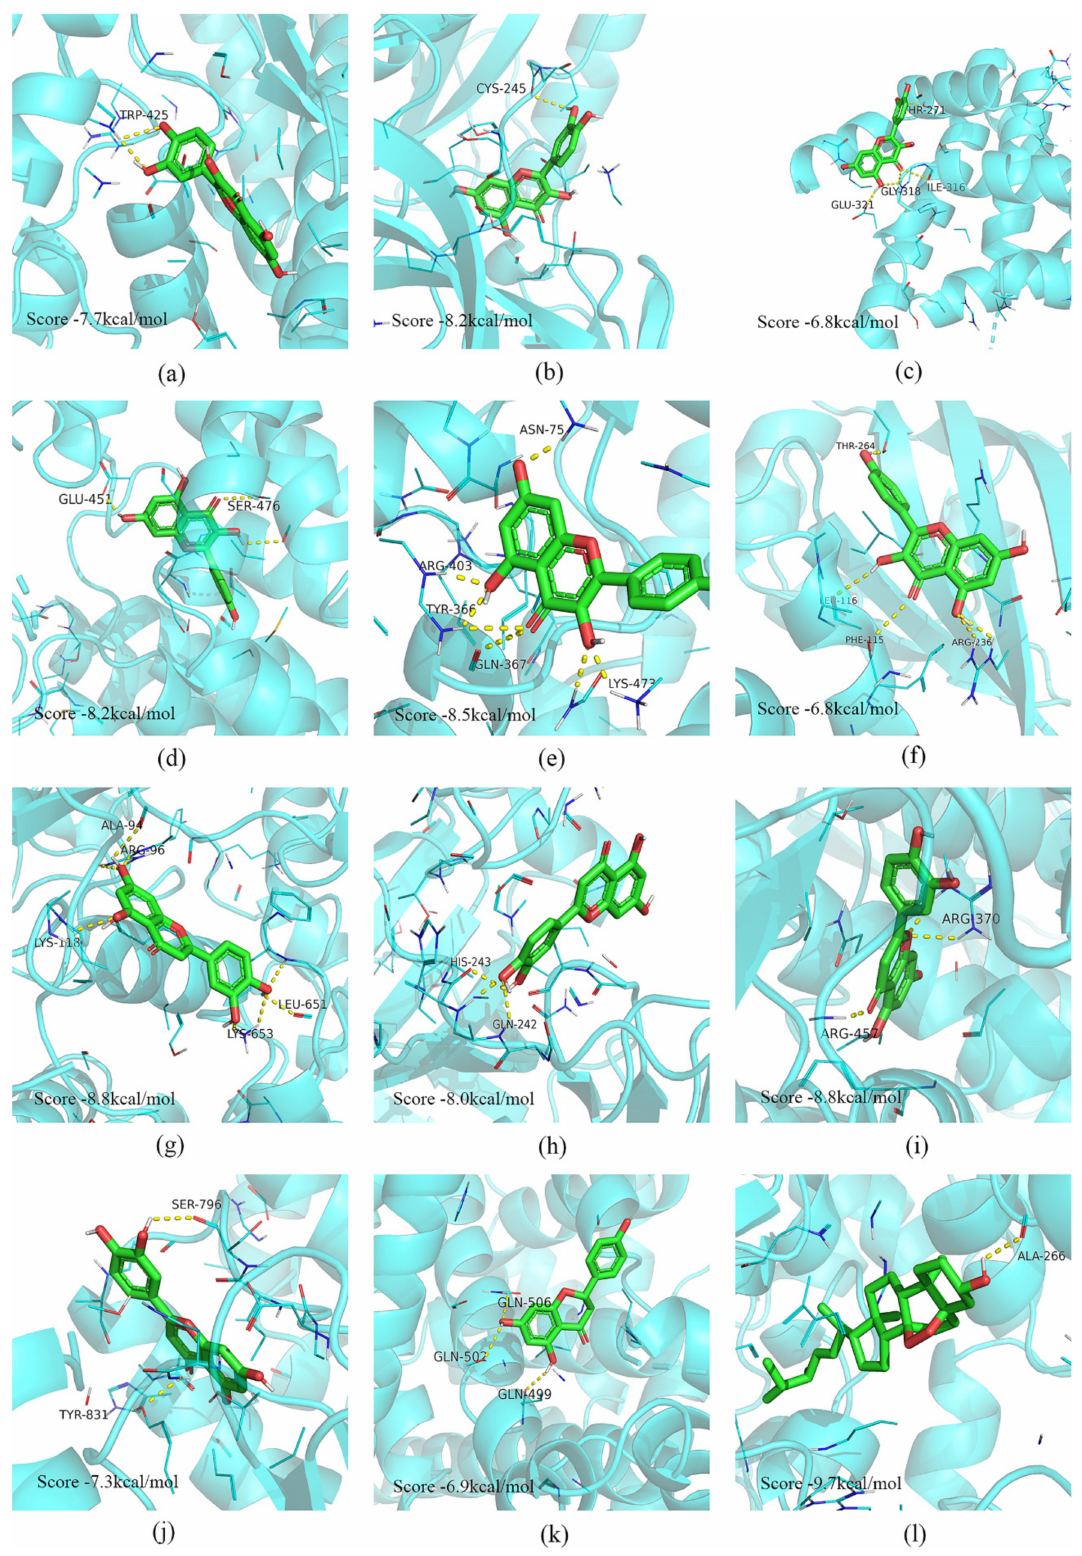
Figure 6. Molecular docking model of vital active ingredients and core targets. ( a ) Quercetin- CYP1B1; ( b ) Quercetin-SRC; ( c ) Quercetin-ESR2; ( d ) Kaempferol-ABCG2; ( e ) Kaempferol-CYP19A1; ( f ) Kaempferol-AhR; ( g ) Luteolin-ABCG2; ( h ) Luteolin-CA4; ( i ) Luteolin-ALOX5; ( j ) Luteolin-ABCC1; ( k ) Naringenin-ESR1; ( l ) Ergosterol